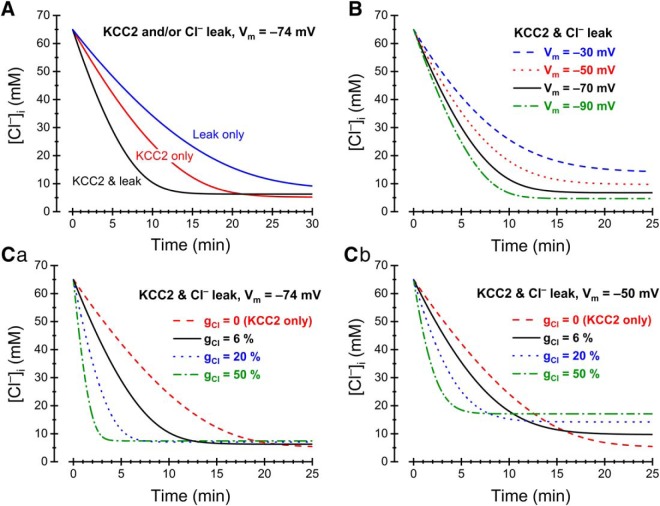
Computed [Cl–]i recovery. Dependence on gCl, gKCC2, and Vm. A, Recovery mediated by KCC2 only (red, middle), Cl– leak only (blue, top), or a combination of KCC2 and Cl– leak (black, bottom) at Vm = –74 mV. B, Recovery mediated by KCC2 and Cl– leak in combination at different Vm, as indicated. Note that the rate of recovery as well as the asymptotic steady-state [Cl–]i depends on Vm. C, Recovery mediated by KCC2 and Cl– leak in combination at different relative gCl, as indicated and at Vm = –74 mV (Ca) or Vm = –50 mV (Cb). Note that the speed of recovery increases with gCl and that the asymptotic steady-state [Cl–]i also increases with gCl. The latter effect is weak at –74 mV (Ca) but prominent at –50 mV (Cb). The transport capacity of KCC2 in (A–C) was adjusted by setting the transporter proportionality factor (apparent conductance; Johansson et al., 2016) gKCC2 to 6.7 10−21 mol2 V−1 C−1 s−1, to match modeled KCC2-mediated [Cl–]i recovery time course to experimental results.